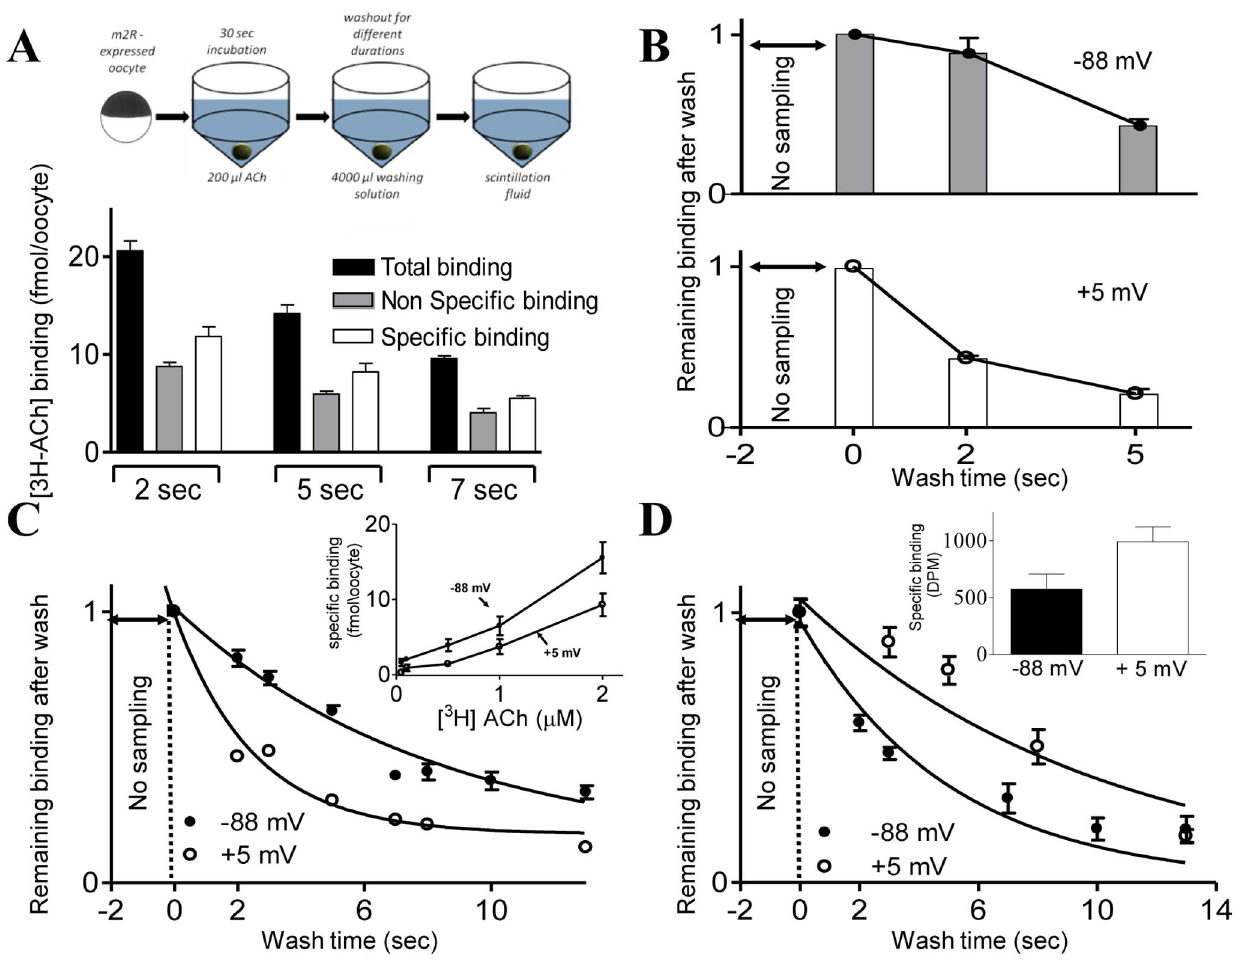
Figure 1. The dissociation rate of [ 3 H]ACh from m2R-expressed oocytes is voltage dependent. (A, top ) The measurement procedure (see Materials and Methods and [7]). (A, bottom ) An example of data obtained from one experiment at resting membrane potential. Results after 2, 5 and 7 sec washout are shown (n=9, 8 and 12 oocyte, respectively) (B) An example from one experiment at two membrane potentials as depicted. The data was normalized as follows: The binding of [ 3 H]ACh was first measured after 2 sec washout in agonist free solution (initial sampling), and then after 2 and 5 sec of additional wash. (C) Collected data from a total of 9 experiments at resting potential ( 2 88 mV) and under depolarization ( + 5 mV) fitted by an exponential decay. Each data point was normalized to the binding of the initial sampling and represents the average 6 SEM of 16–59 oocytes (The SEM values at + 5 mV are smaller than the symbols). Inset , results of binding measurements of [ 3 H]ACh to m2R-expressed oocyte (Taken with permission from [7]). (D) Binding of [ 3 H]ACh to m1R- expressed oocytes after different washout times, at two membrane potentials. Each data point was normalized to the binding of the initial sampling and represents the average 6 SEM of 7 to 57 oocytes. Inset , results of binding measurements of [ 3 H]ACh to m1R-expressed oocyte (Taken with permission from